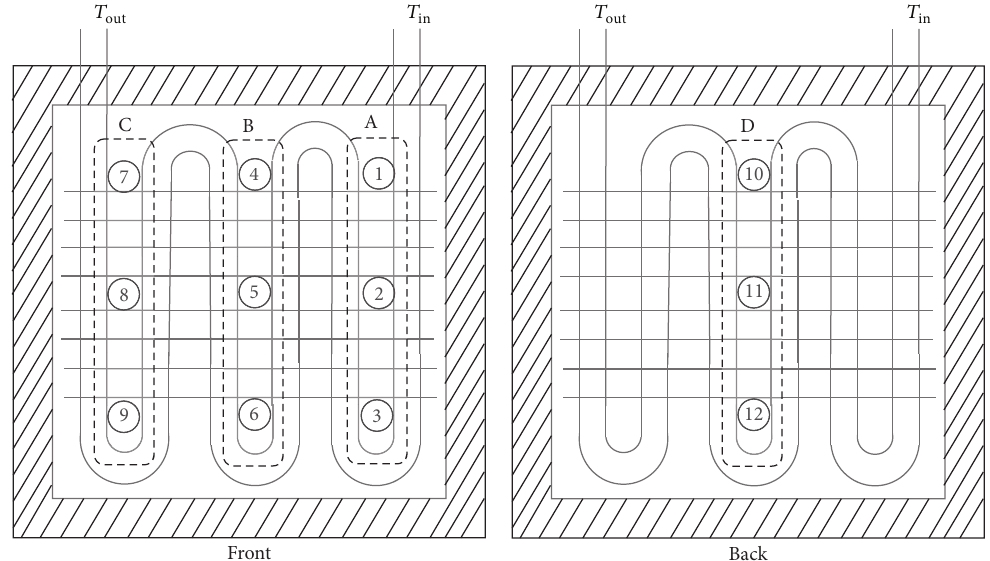
Figure 3: Location of thermocouple position in the control system.